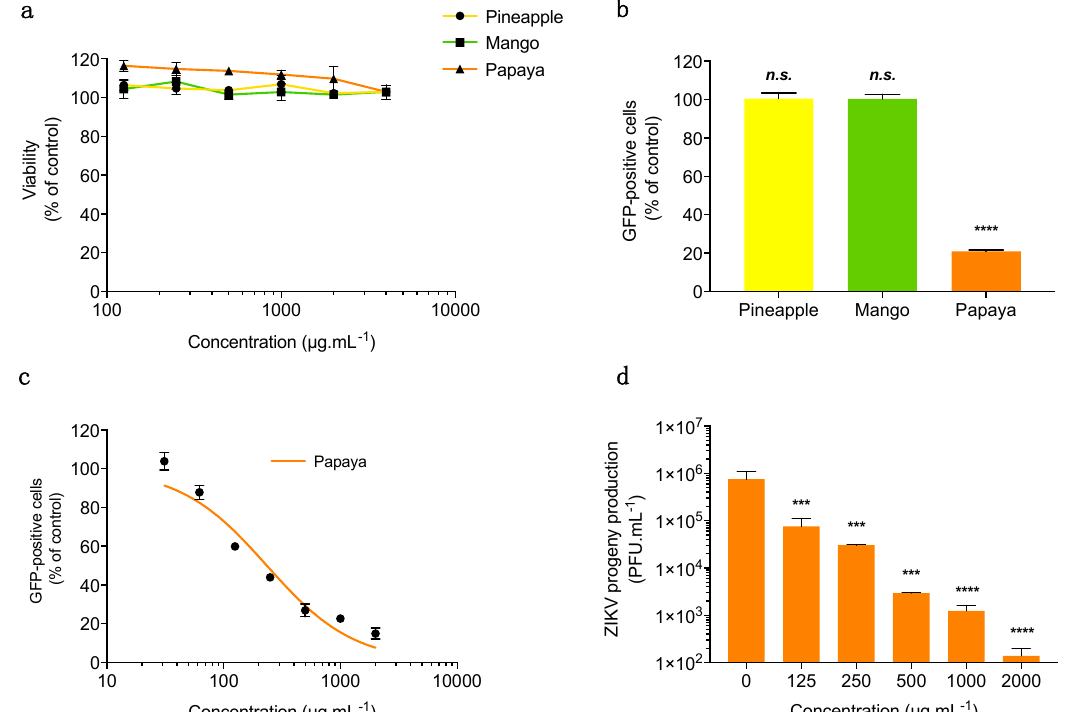
Figure 1. Papaya pulp extract exerts antiviral activity against African and Asian strains of ZIKV in A549 cells. ( a ) A549 cells were incubated with two-fold serial dilutions (125–4000 µg/mL) of pineapple juice, mango or papaya pulp extracts for 48 h. Cell viability was assessed through the MTT assay. Results are means ± standard deviation (SD) of four independent experiments and are expressed as relative value compared to non-treated cells. ( b ) A549 cells were infected with ZIKV GFP at MOI (Multiplicity of Infection) of 2 PFU/cell in the presence of pineapple juice, mango or papaya pulps at